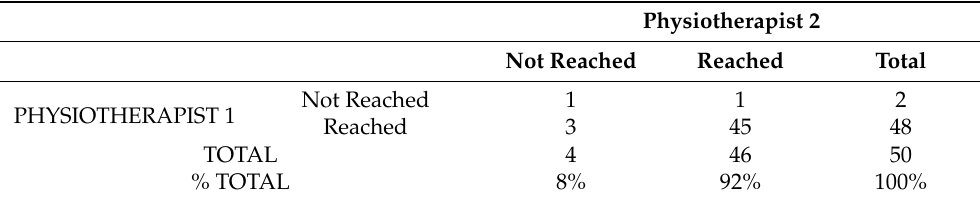
Table 3. Percentage of success for each physiotherapist.